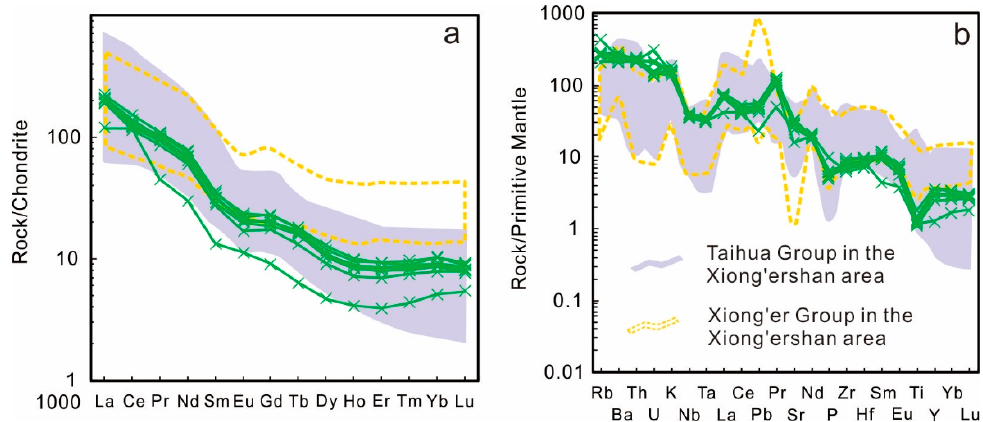
Figure 4. Chondrite-normalized rare earth element (REE) patterns ( a ) and primitive mantle-normalized multi-element diagrams ( b ) for granitoids from the Banzhusi granite porphyry. Whole-rock data for the Taihua Group and Xiong’er Group are shown for comparison [30,36]. Chondrite and primitive mantle normalizing values are from [73].